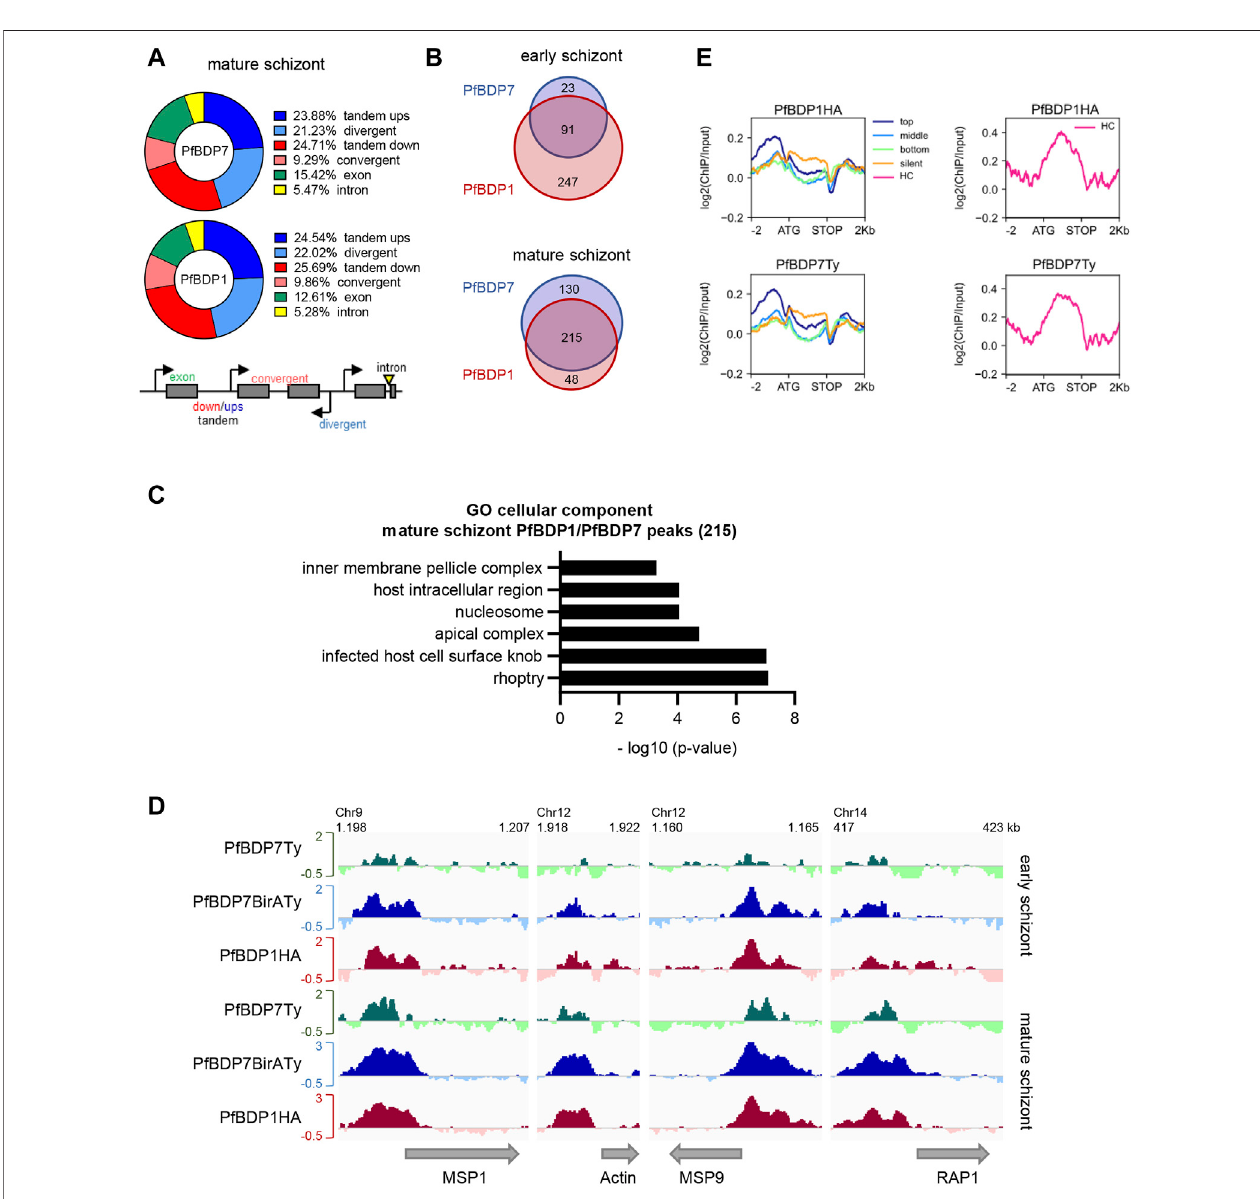
FIGURE 6 | PfBDP7 interacts with PfBDP1 across the genome. Chromatin immunoprecipitation was performed on PfBDP7Ty_GlmS and PfBDP1HA:: PfBDP7BirATyparasitesinearlyandmature schizont stageparasites. (A) Chartdepicting %ofPfBDP7andPfBDP1peaks localizedinthespeci fi edgenomic features in PfBDP1HA::PfBDP7BirATy mature schizont stage parasites. Ups = upstream, down = downstream. The relative orientation of genetic elements is indicated in the scheme. (B) Venn diagram visualizing overlap of genes closest to PfBDP1 and PfBDP7 peaks in early and mature PfBDP1HA::PfBDP7BirATy schizont stage parasites. (C) Geneontology(GO)analysisofgenesclosesttocommonPfBDP1andPfBDP7peaksinmatureschizonts.Themostsigni fi cant,non-redundantGOterms concerning “ cellular component ” are presented. (D) Enrichment pro fi les [log 2 (ChIP/Input)] of PfBDP7 and PfBDP1 in selected invasion genes. Green: PfBDP7Ty (from PfBDP7Ty_GlmS parasite ChIP); blue: PfBDP7BirATy and red: PfBDP1HA (from PfBDP1HA::PfBDP7BirATy parasite ChIP). (E) Line plots of log2 (ChIP/Input) ratios for PfBDP7 and PfBDP1 in mature PfBDP1HA::PfBDP7BirATy schizont stage parasites. Euchromatin associated genes were ranked into top, medium, bottom or non- expressed genes (silent) by schizont stage expression. Heterochromatin (HC) associated genes were plotted separately (right panels, pink lines).